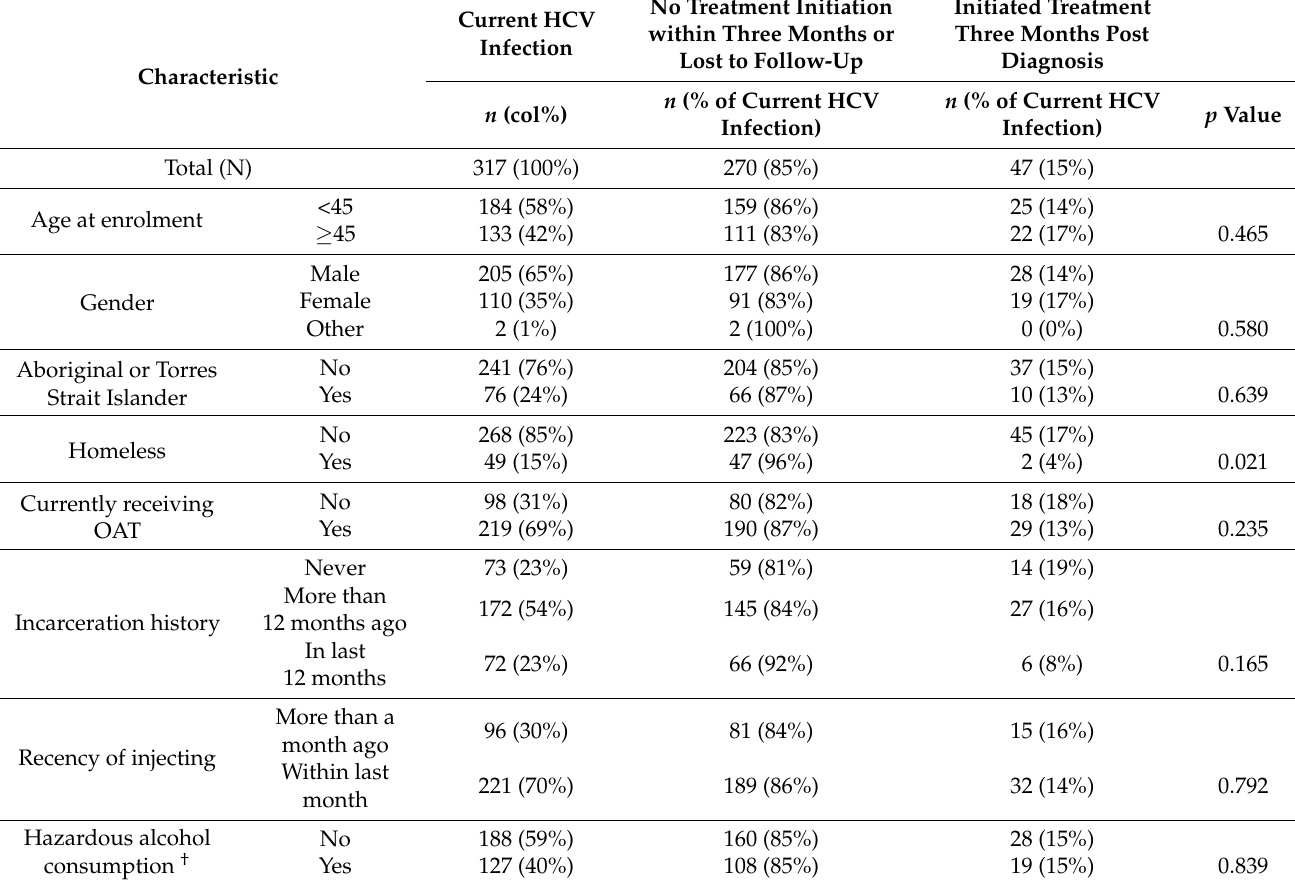
Table 1. Baseline characteristics of people with HCV infection, by treatment initiation status three months following HCV diagnosis in ETHOS Engage ( n =